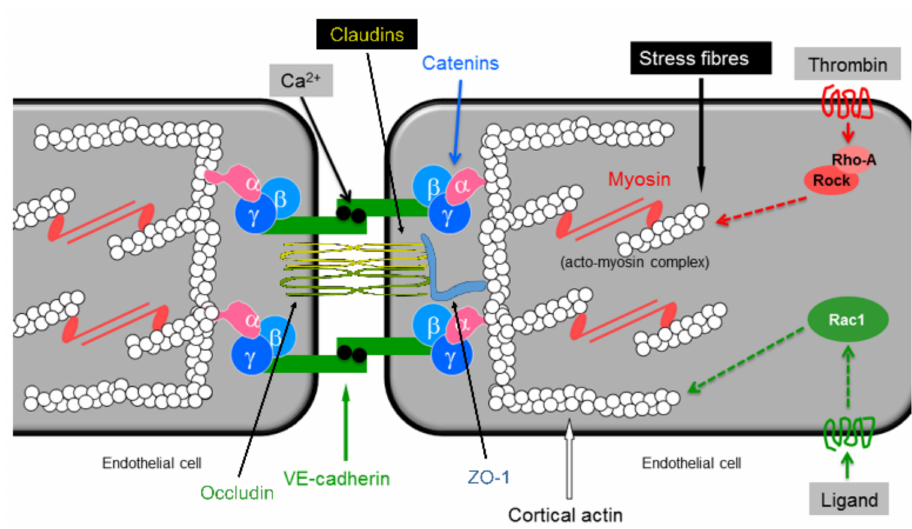
Figure 1. Schematic presentation of regulators of endothelial barrier properties. Rock: Rho associated kinase Endothelial barrier integrity is influenced by several circulating, blood-borne hor- mones and agents/factors such as adenosine triphosphate (ATP) and its metabolites adeno- sine diphosphate (ADP) and adenosine. The major sources of vascular nucleotides are erythrocytes, platelets, and the endothelium [16]. Platelets contain nucleotides in their granules, and upon degranulation, bulk plasma levels of ATP can reach 50 µ M [17], with even higher local concentrations predicted at the endothelial surface [18]. The endothelium releases nucleotides in response to shear stress [19], inflammatory mediators like throm- bin [20], and hypoxia [21,22]. ATP and other nucleotides either released from vascular cells or applied exogenously can act at endothelial purinoceptors and modulate the barrier function of the endothelium [21,23,24]. Activation of purinergic receptors also induces the release of von Willebrand Factor (vWF) from ECs [25], which via reactive oxygen species (ROS)-dependent upregulation of endothelin-1 [26] may modulate endothelial barrier